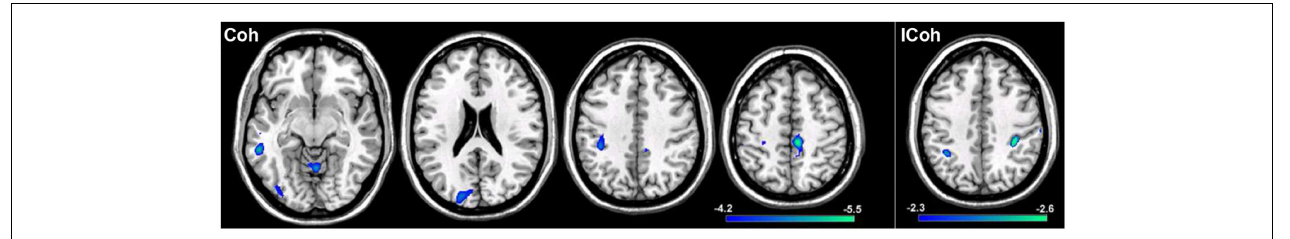
in blue. Left panel: difference maps for Coh reconstructions of connections in affected M1 (left to right, Z = 63, 94, 112, 142). Right panel: difference maps for ICoh reconstructions of connections in affected M1 ( Z = 115). Conventions as in previous figures.